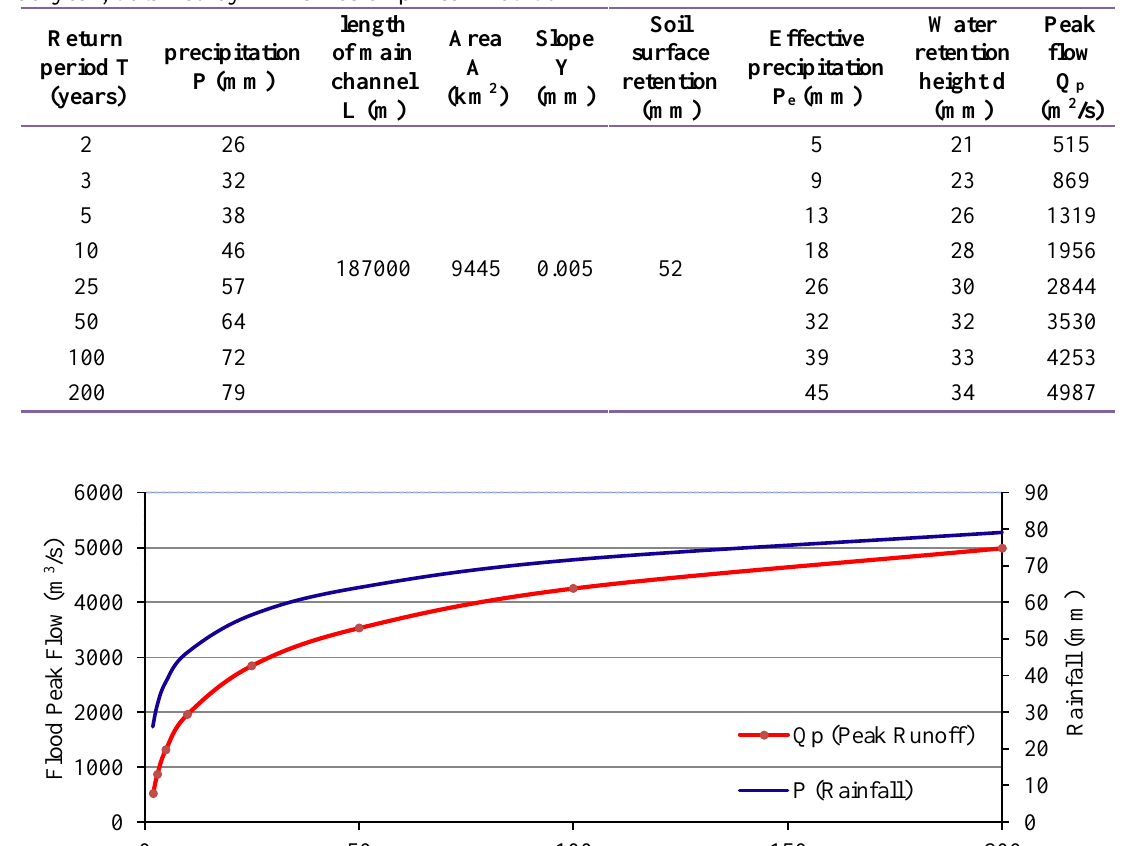
Table 3. The results of estimation of runoff peak flow in Iranshahr catchment for return periods of 2 to 200-year, obtained by El-Hames empirical method